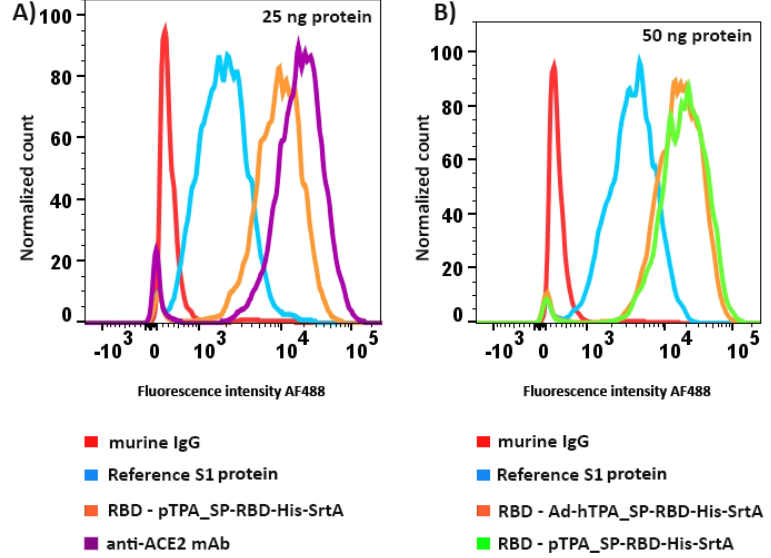
Figure 5. Histograms of the flow cytometer analysis for evaluation of RBD binding to human ACE2 expressed by a stably transfected HEK293 cell line in culture. ( A ) Direct binding assessment of S1 reference protein and highly purified RBD obtained by the transient transfection mode of production in this work. Binding of unrelated murine IgG or the high-affinity of an anti-ACE2 monoclonal antibody is also shown. ( B ) Simultaneous assessment of binding to ACE2 of S1 reference protein and RBD obtained by the two methods of production; transient transfection and adenoviral infection of HEK293SF suspension cells. For detection, an anti-His tag monoclonal antibody conjugated to Alexa Fluor 488 was used. Binding of the anti-ACE2 monoclonal antibody was run as the positive control in the whole experiment. RBD was assayed at a concentration of 0.25 µg/mL (panel A) and 0.5 µg/mL (panel B).